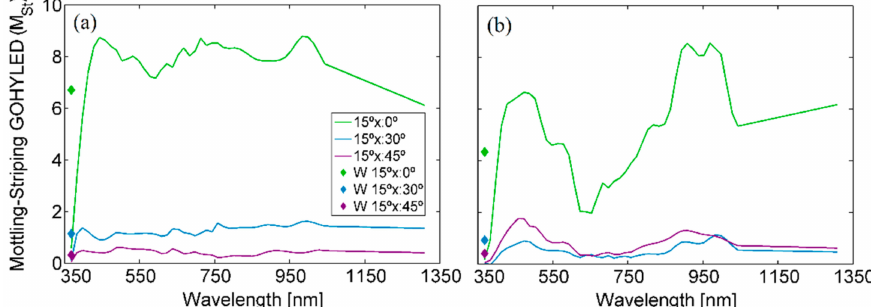
Figure 11. Mottling-striping spectra M St of ( a ) the grey and ( b ) the blue sample with striping. The M St related to the white LED cluster (W) is represented by diamond